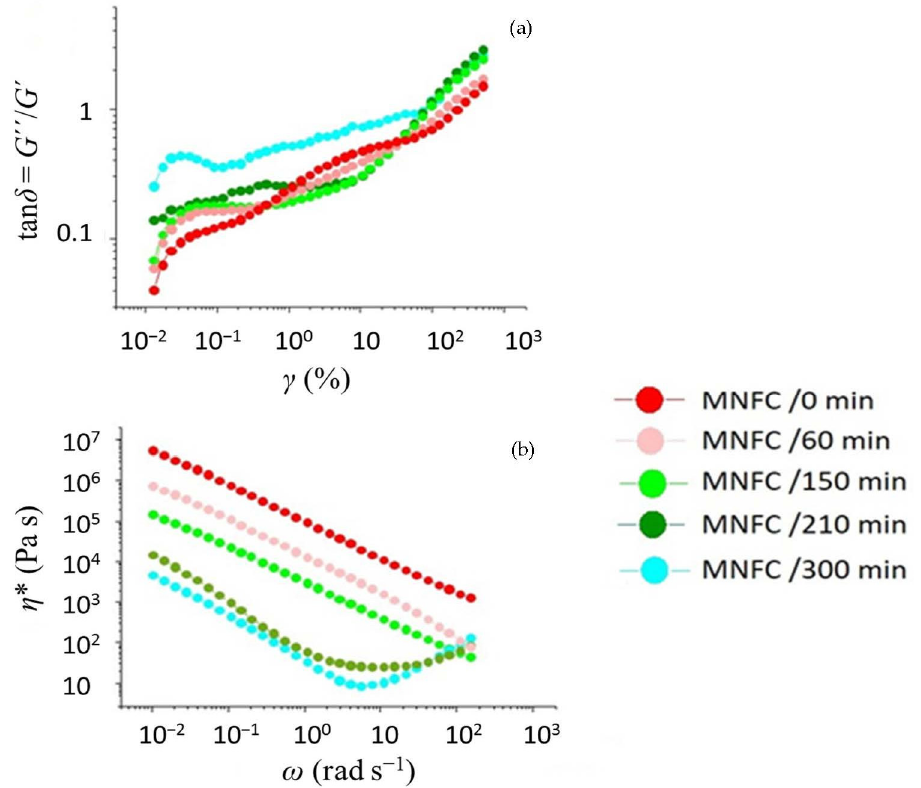
Figure 6. Flow curves of MNFC suspensions showing the progressive effect of enzymatic pretreat- ment time: ( a ) phase response, tan δ , to strain, γ , ( b ) complex viscosity, η *, response to angular frequency, ω